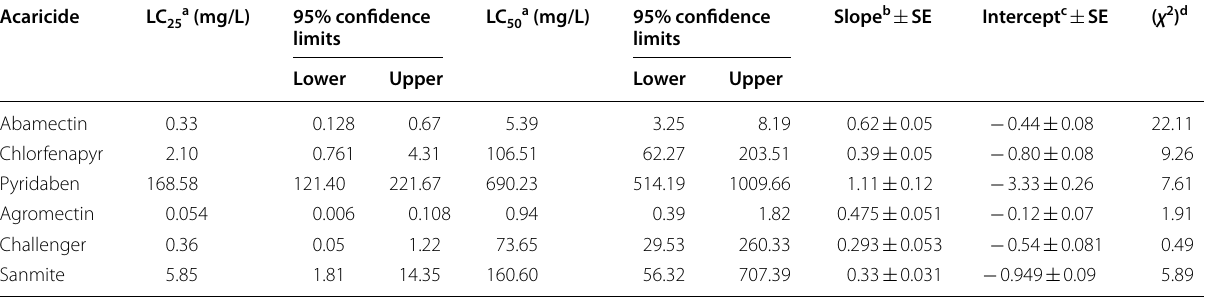
Table 2 Acaricidal activity of technical (abamectin, chlorfenapyr, and pyridaben) and formulated (Agromectin, Challenger, and Sanmite) acaricides against adult females of two-spotted spider mite T. urticae after 24 h by slide-dip technique